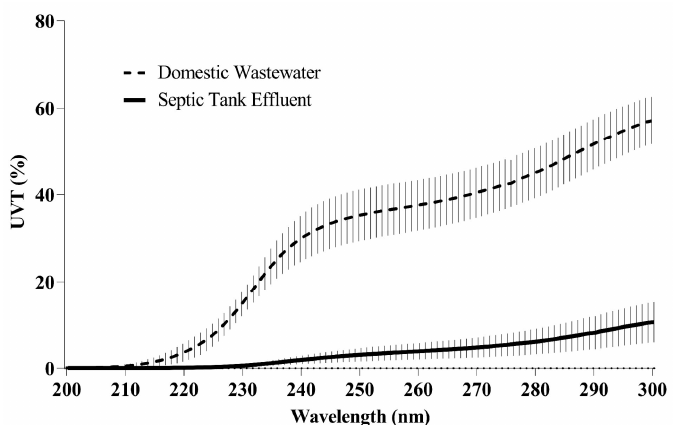
Figure 5. UV transmittance spectra of wastewater and septic tank from the WFMF permeate prior to UV exposure. Data represents average plus standard deviation.